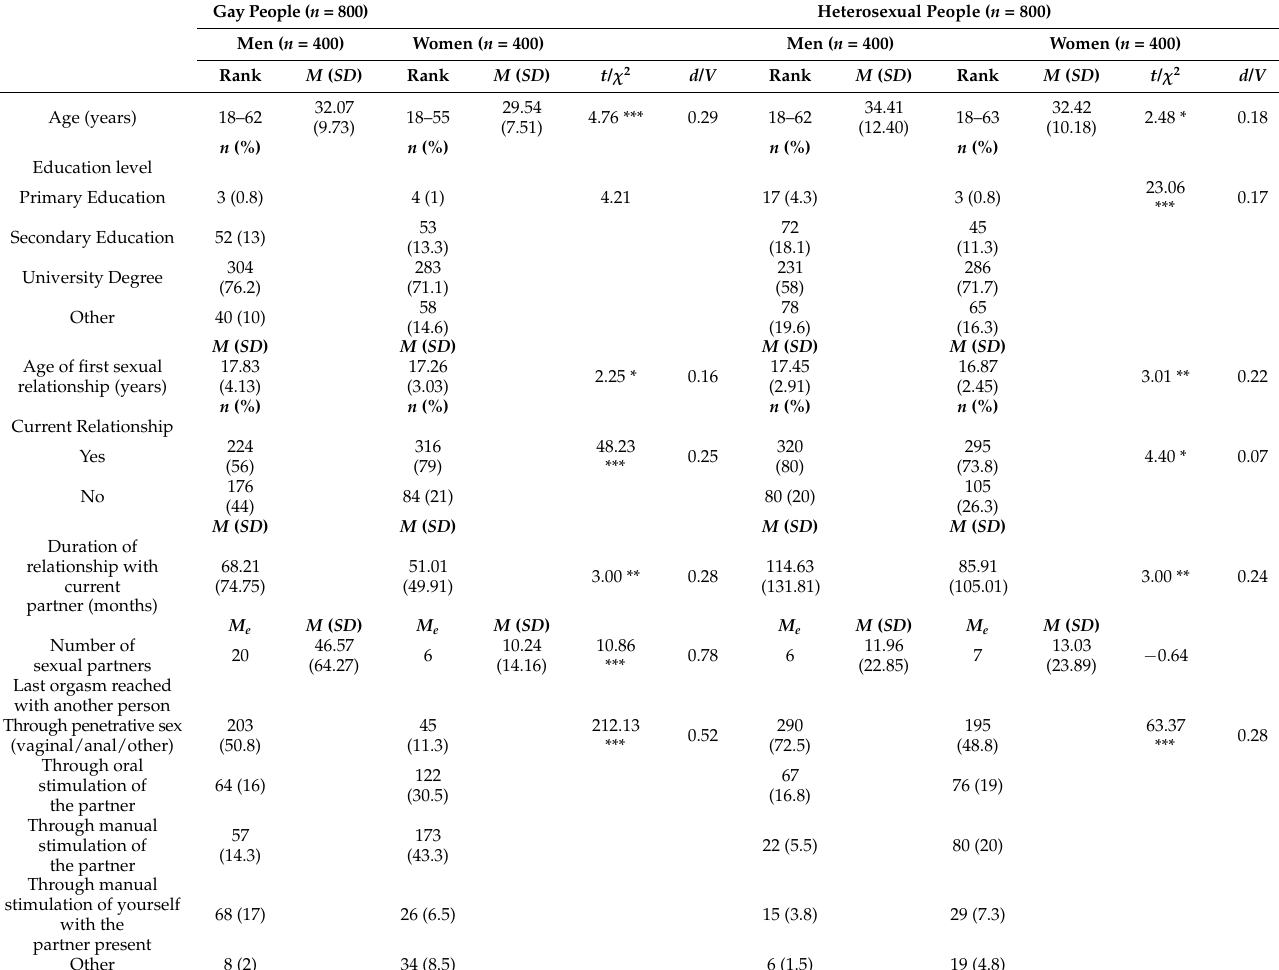
Table 1. Sociodemographic characteristics of the